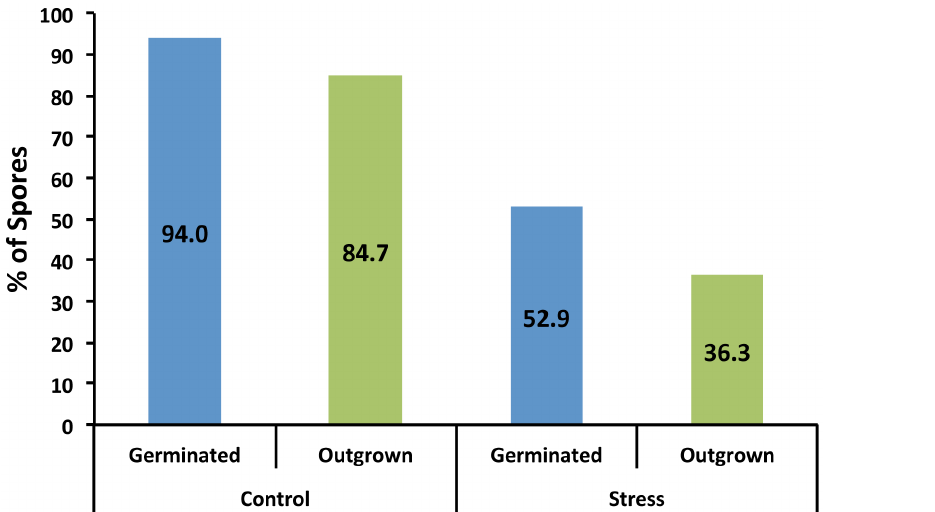
Figure 6. Heat-treated spores show a decrease in the overall number of spores that are able to germinate and grow out within 5 hours. Movies of heat- (85 u C for 10 min) and un- treated spores (see Fig. 4 and 5 for details) were analyzed with SporeTracker and the spores were scored (by additional manual inspection) for their ability to germinate and grow out. The total number of spores assessed in the control and stress condition was 218 and 325, respectively.